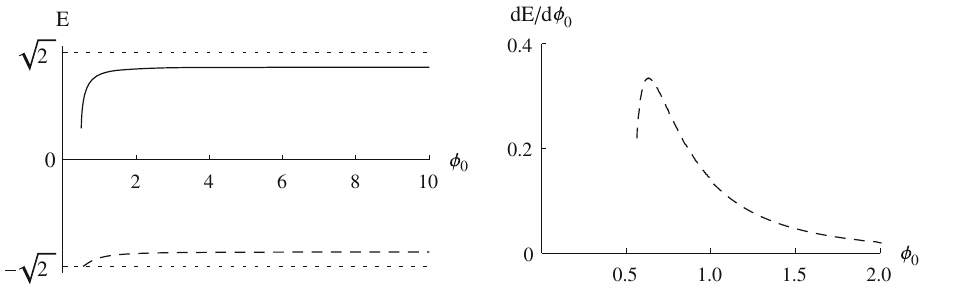
Fig. 3 Left graph the fermionic bound energies as a function of φ 0 . Solid and dashed curves depict the positive and negative fermionic bound energies, respectively, in the dynamical model. Dotted lines